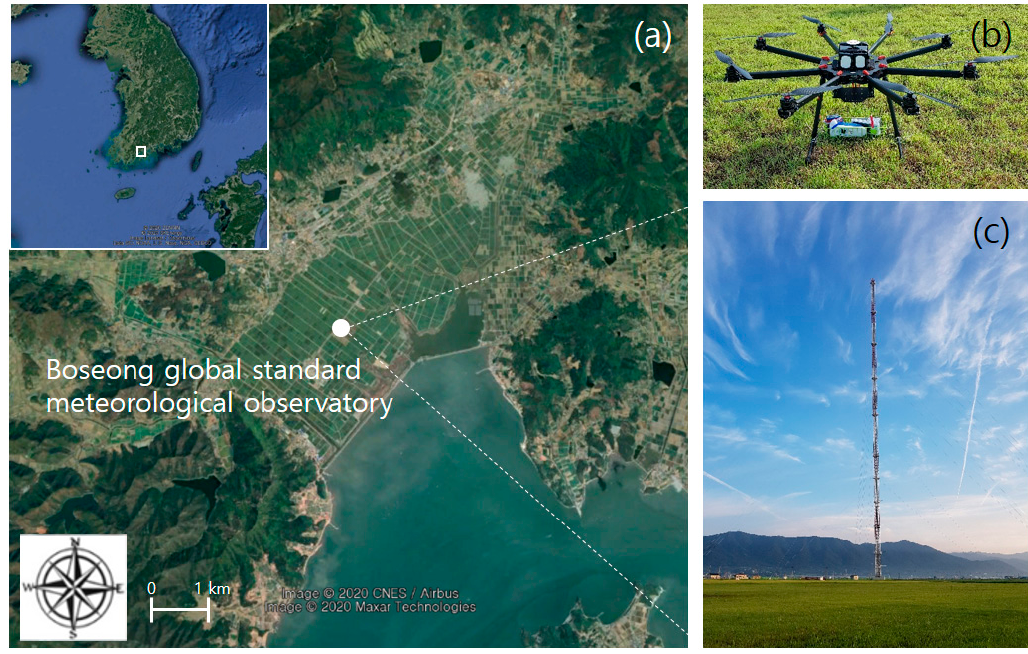
Figure 1. ( a ) Map showing the location of Boseong global standard meteorological observatory (source: Google Earth); images of ( b ) rotary-wing UAV (unmanned aerial vehicle) and ( c ) 307-m tall meteorological observation tower.